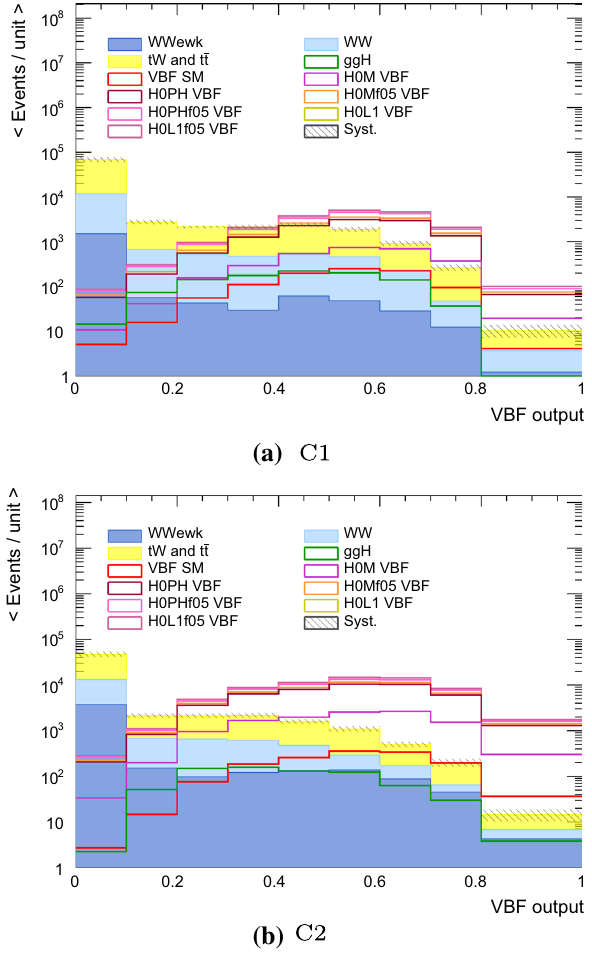
Fig. 7 Distribution of the VBF-output of both the ADNNs in the cor- responding STXS bin. The VBF signals are shown superimposed on backgrounds templates, which are instead drawn stacked on top of each other. A logarithmic scale is used. The dashed uncertainty band corre- sponds to the total systematic uncertainty in the background templates nal models are shown. The different shapes are due to the presence of input features that have distributions strongly dependent on the theoretical signal modeling, such as m H (cid:9)η jj , H T and p T of the jets.